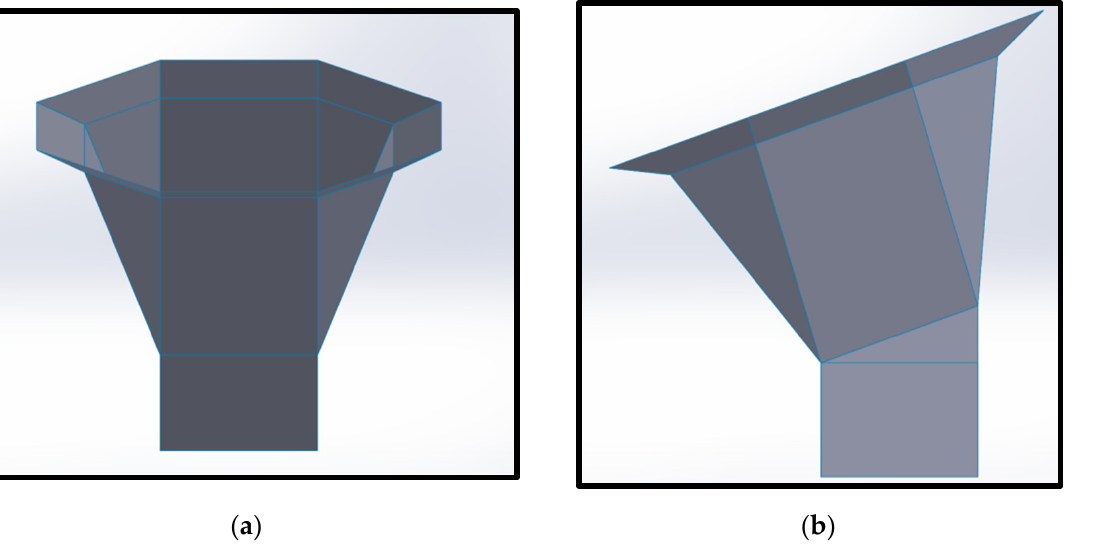
Figure 1. ( a ) Front view of the funnel-type solar cooker. ( b ) Side view of the funnel-type solar cooker. Before making the above design into a prototype, a check was made if the funnel is able to direct light on to the box of the solar cooker. To test this, a ray diagram of the solar cooker made from the side view for a solar angle of 62 ◦ . An online tool is used to make the ray diagram of the solar cooker from the side view [13]. The light rays from the sun are taken to be parallel to each other, because light rays coming from infinity are taken to be parallel and the sun is a large distance from the Earth. The ray diagram is shown in Figure